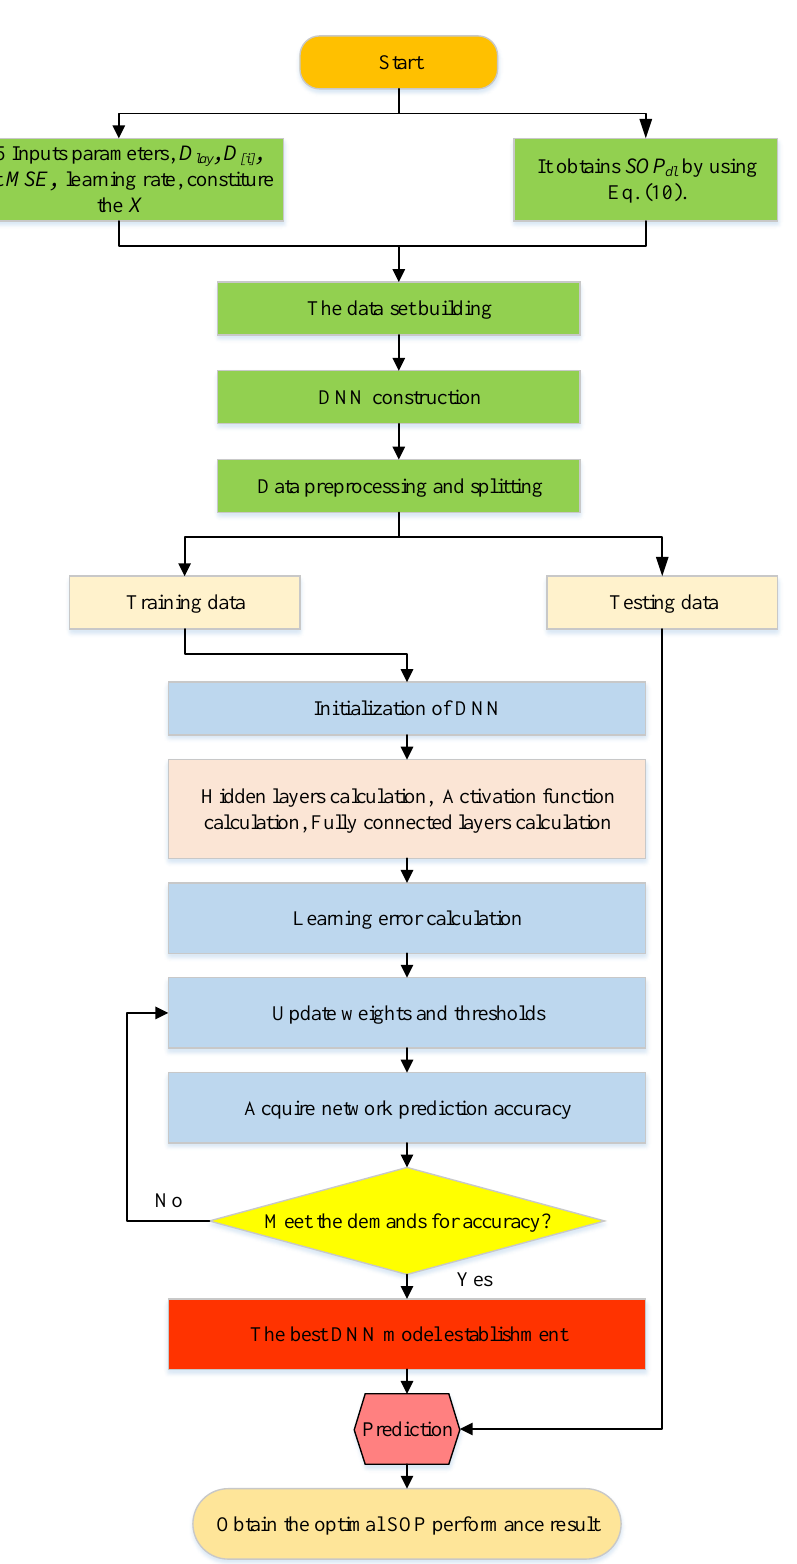
Figure 5. SOP prediction